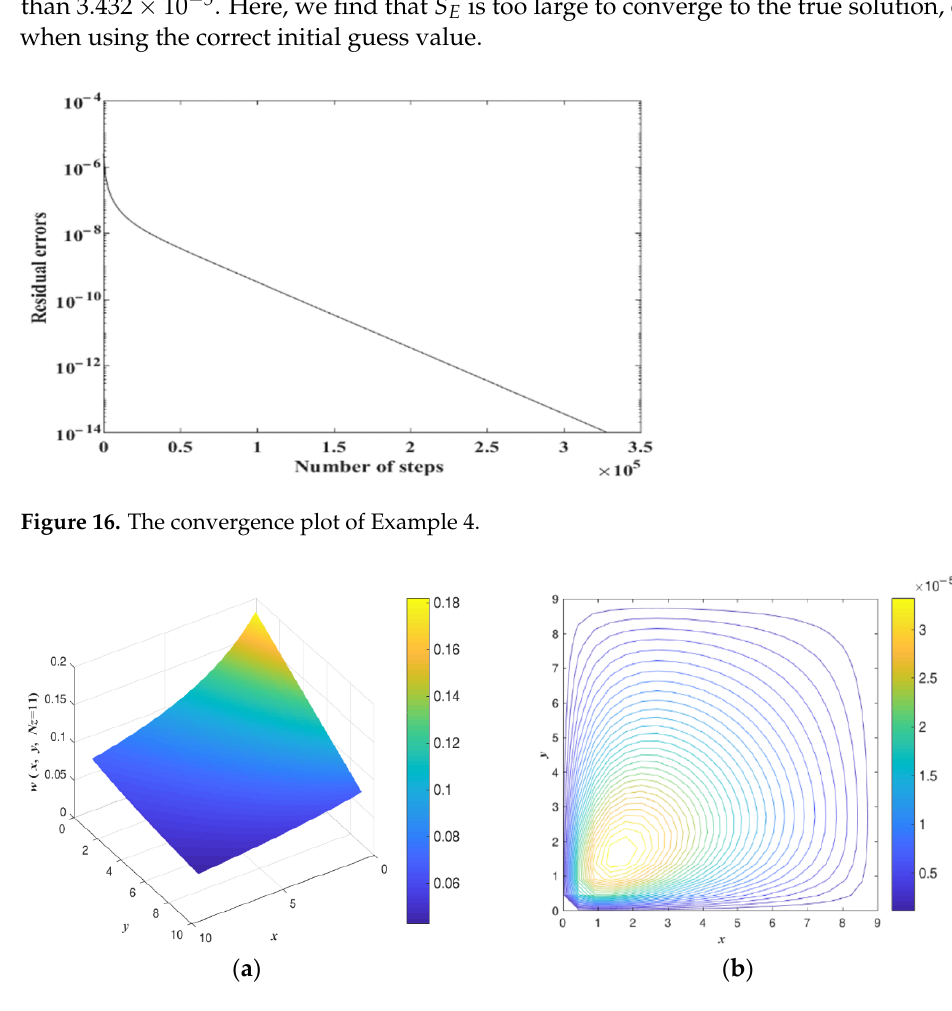
Figure 16. The numerical results and absolute errors on the z = 4.5 plane are plotted in